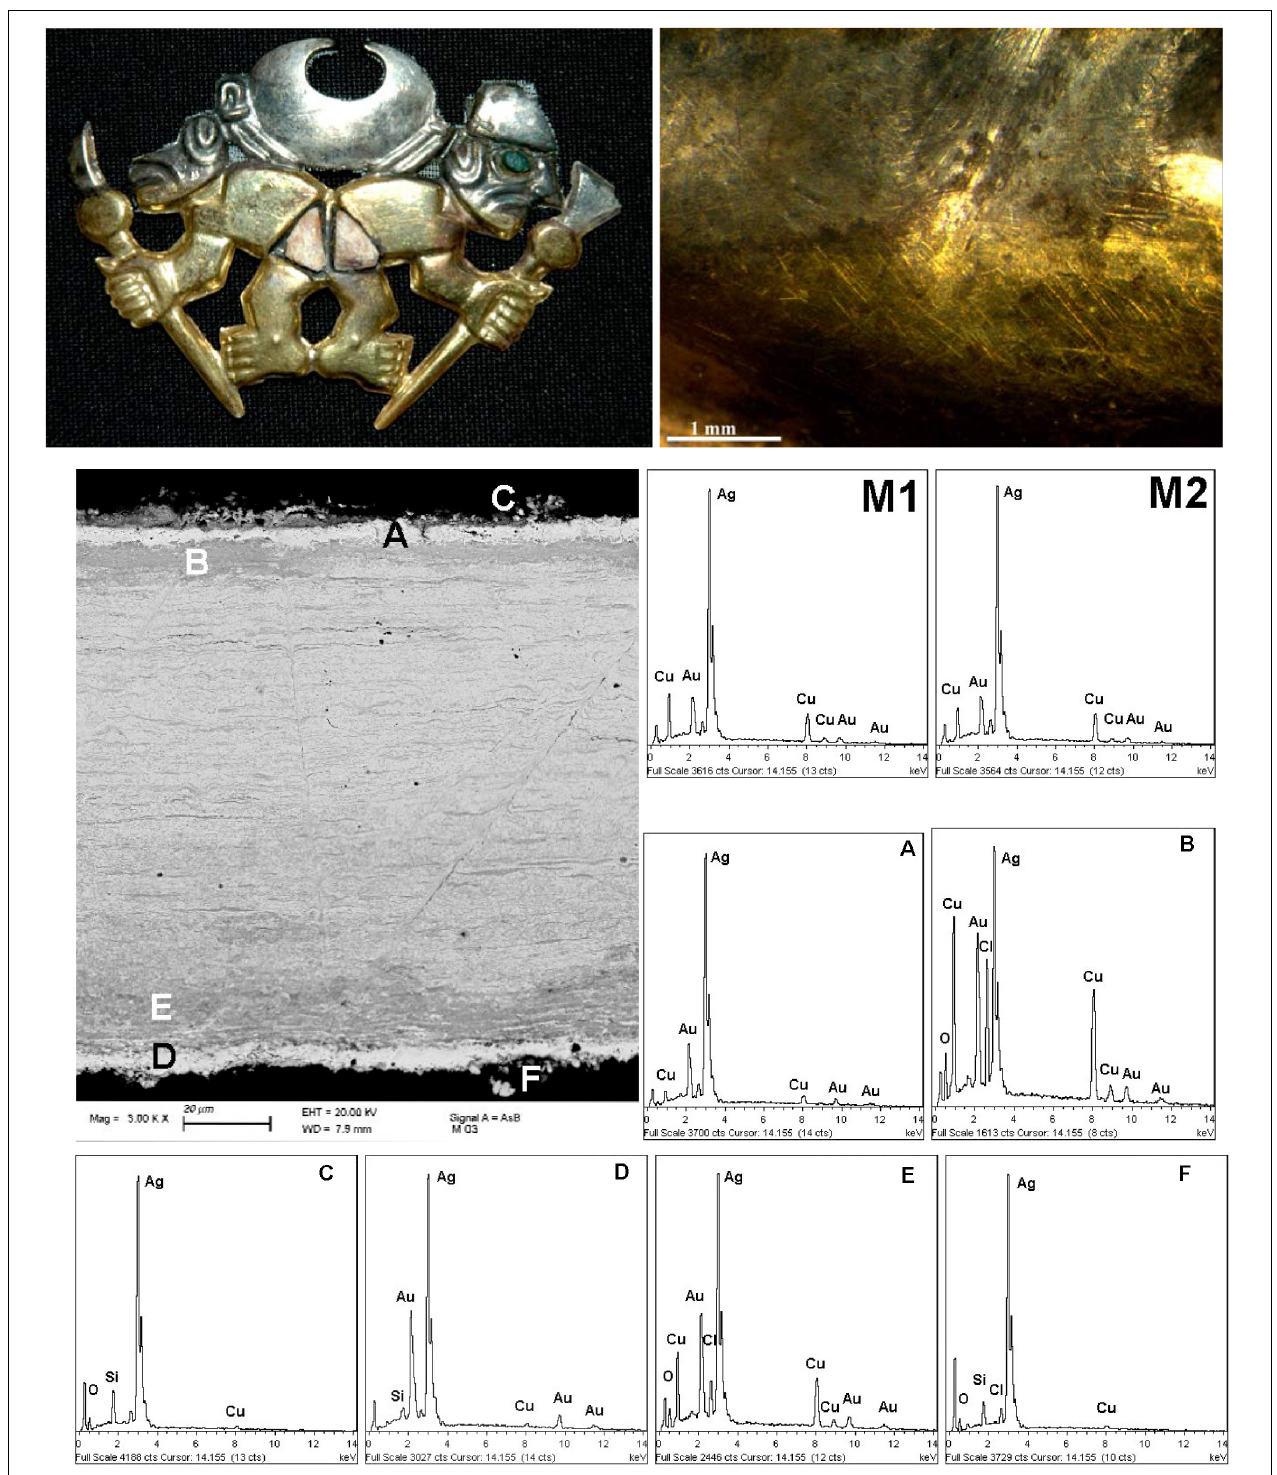
FIGURE 5 | The nariguera F4-03 from the tomb of the Lady of Cao and an optical image the interface between the “gold” and the “silver” areas, on the left and right side of the first raw, respectively. SEM images and EDS spectra (M1, M2, A–F ) of the different areas of a cross-sectioned fragment of the nose ornament taken in the silvered area of the head of the animal on the left, second and third raw, respectively. The EDS elemental semi-quantitative composition (expressed as wt%) are reported in Table 1 .